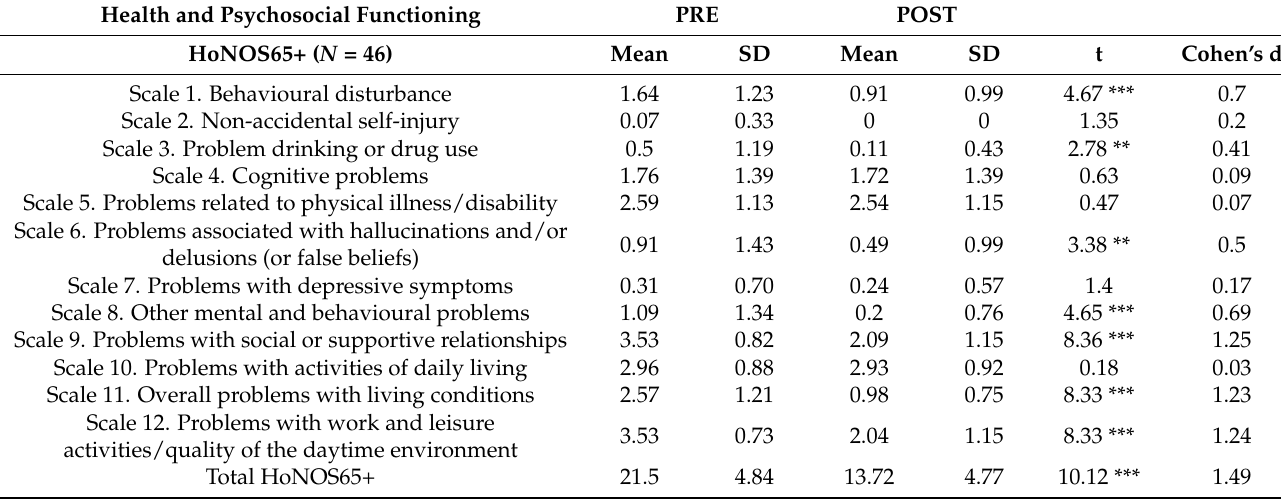
Table 4. HoNOS65+ scales. Difference in the pre-/post-intervention